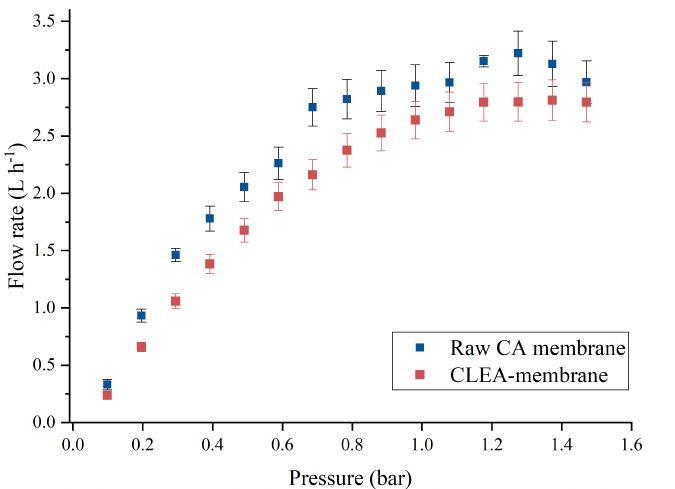
Figure 8. Effect of transmembrane pressure on membrane flux. Raw cellulose acetate membrane was used without any pre-treatment except washing with distilled water. Error bars represent the standard deviation of multiple flow measurements with specific